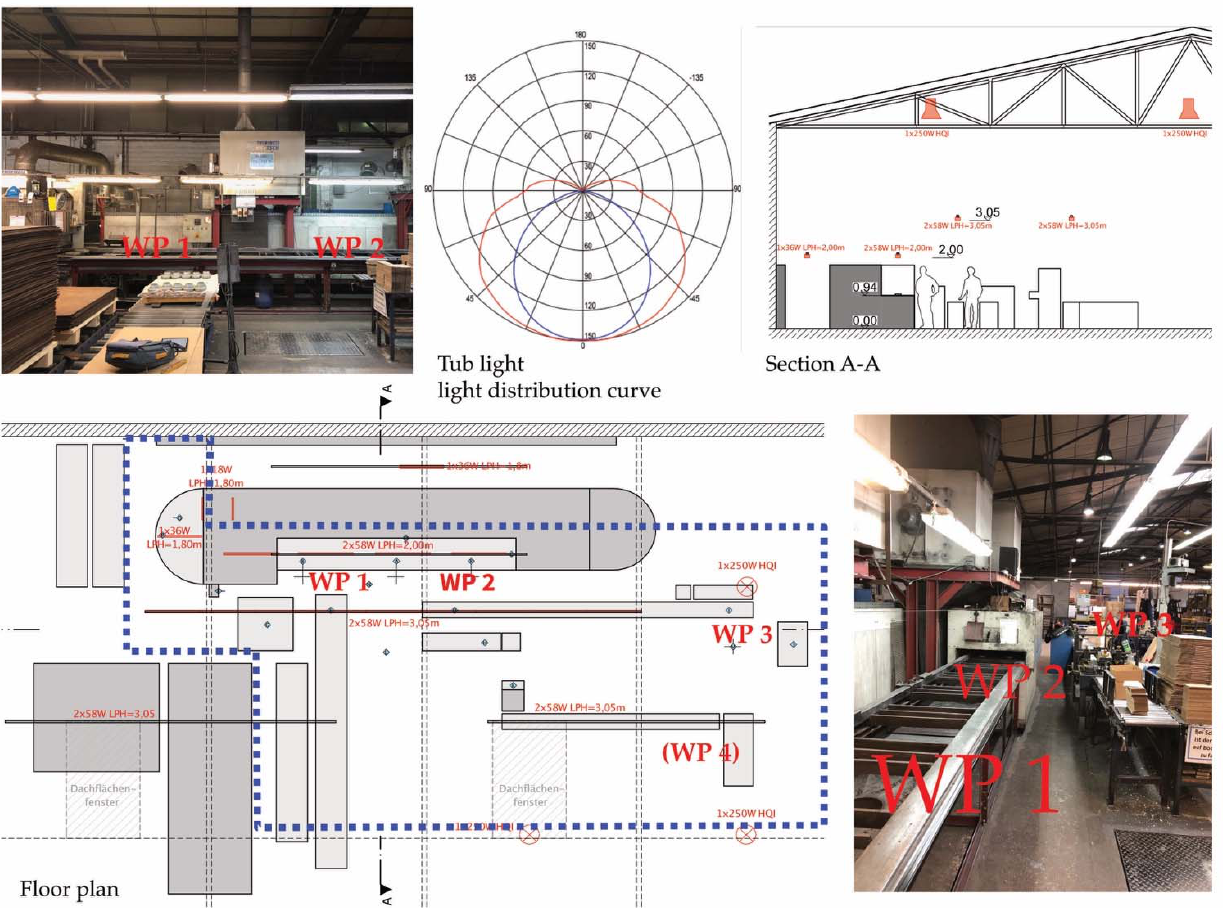
Figure 1. Stock lighting situation. The figure shows a floor plan with the workplaces WP 1–WP 4. WP 1 and WP 2 are quality control workplaces. WP 3 and the seldom used WP 4 are packaging workplaces. The rest of the area is storage and movement area. The relevant area is surrounded by a blue dotted line. Two gray hatched rectangles show the position of skylights. Section A-A shows a cut through the quality control workplaces. Red markings in the floor plan and section show stock lighting positions. Two photographs show the main workplace (WP 1 and WP 2).